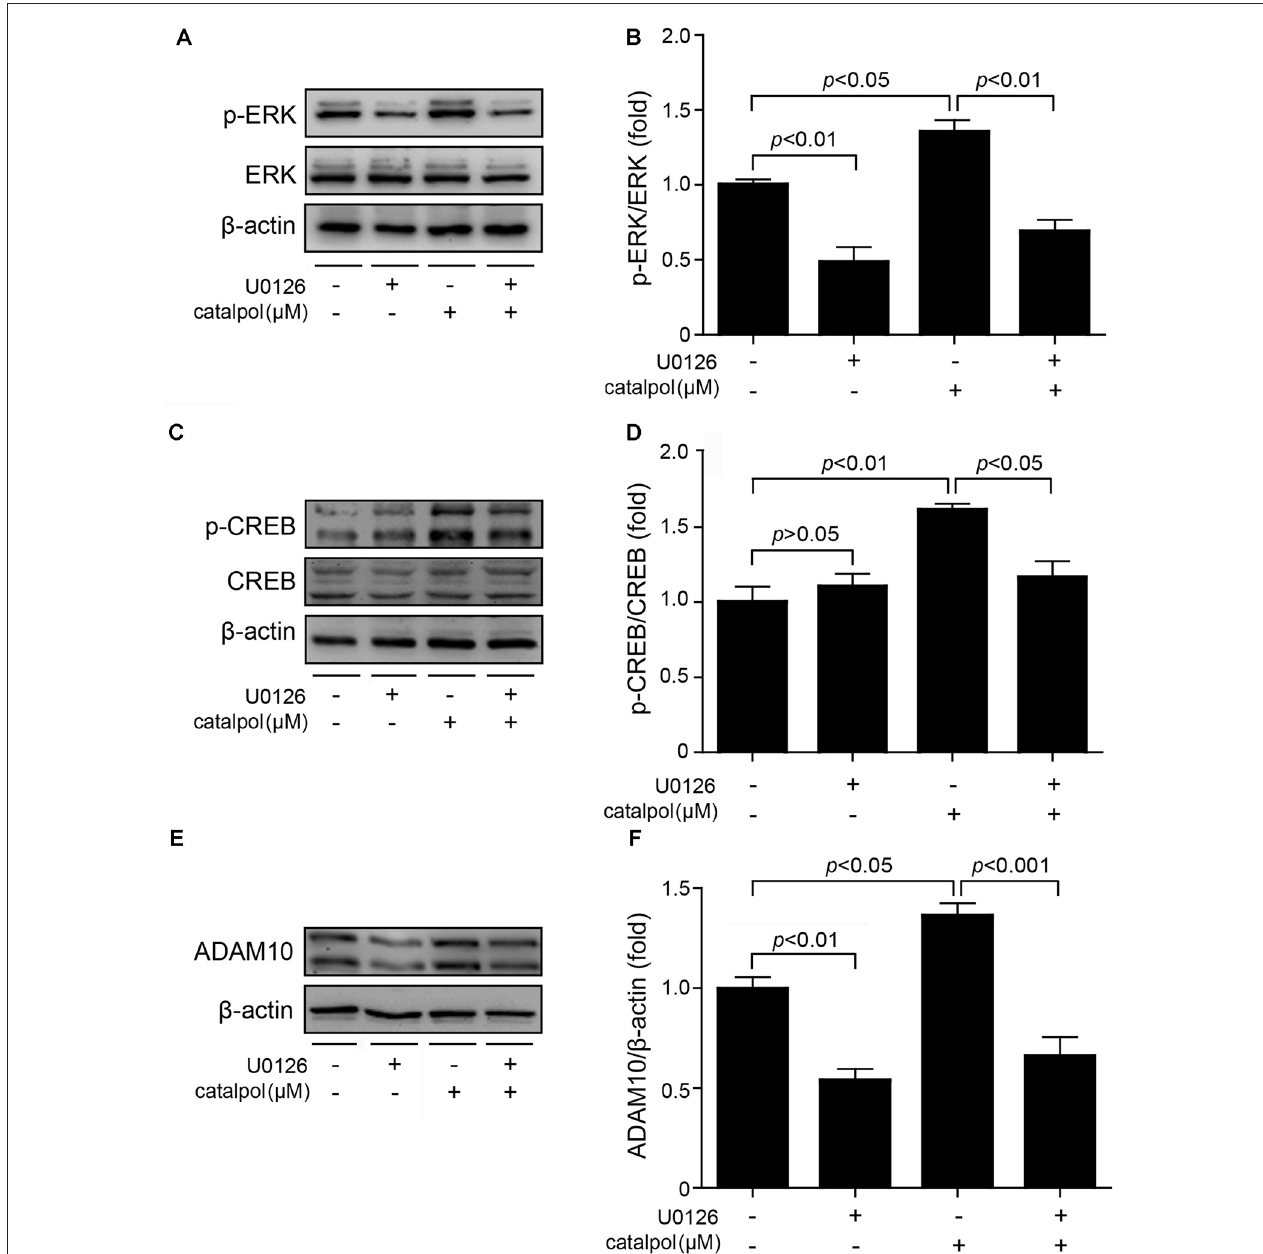
FIGURE 6 | Catalpol promoted ADAM10 expression through ERK/CREB signaling pathway. SweAPP N2a cells were pre-treated with the ERK inhibitor U0126 for 2 h, and then treated with 200 µ M catalpol for 1 h. (A,C) Immunoblot images and (B,D) quantifications show that the expression levels of p-ERK/ERK and p-CREB/CREB were assessed by western blot. The expression levels of p-ERK and p-CREB were markedly decreased in cells treated with both U0126 and catalpol, compared with catalpol-treated cells. (E,F) SweAPP N2a cells were pre-treated with U0126 for 2 h, followed by treating with 200 µ M catalpol for 18 h. Cells treated with both U0126 and catalpol showed significant decreased levels of ADAM10 protein ( E , representative pictures; F , quantification), compare to these from catalpol-treated cells. The data are expressed as the mean ± SEM. n = 3. The p values were calculated using one-way ANOVA.